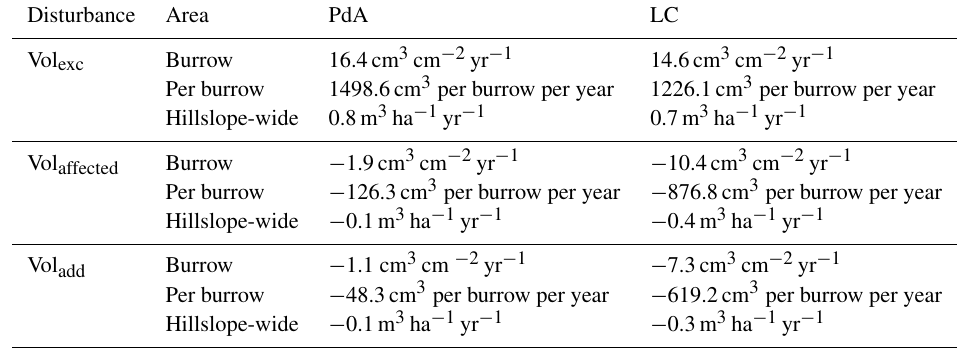
Table 2. Summary of the volume of redistributed sediment according to area and disturbance type. Vol exc describes volume of the sediment excavated by the animals. Vol burrow describes volume of the sediment redistributed during rainfall events within burrows. Vol add describes the difference in redistributed sediment volume within burrows and burrow embedding areas during rainfall. Positive values indicate sediment accumulation, while negative values indicate sediment erosion.